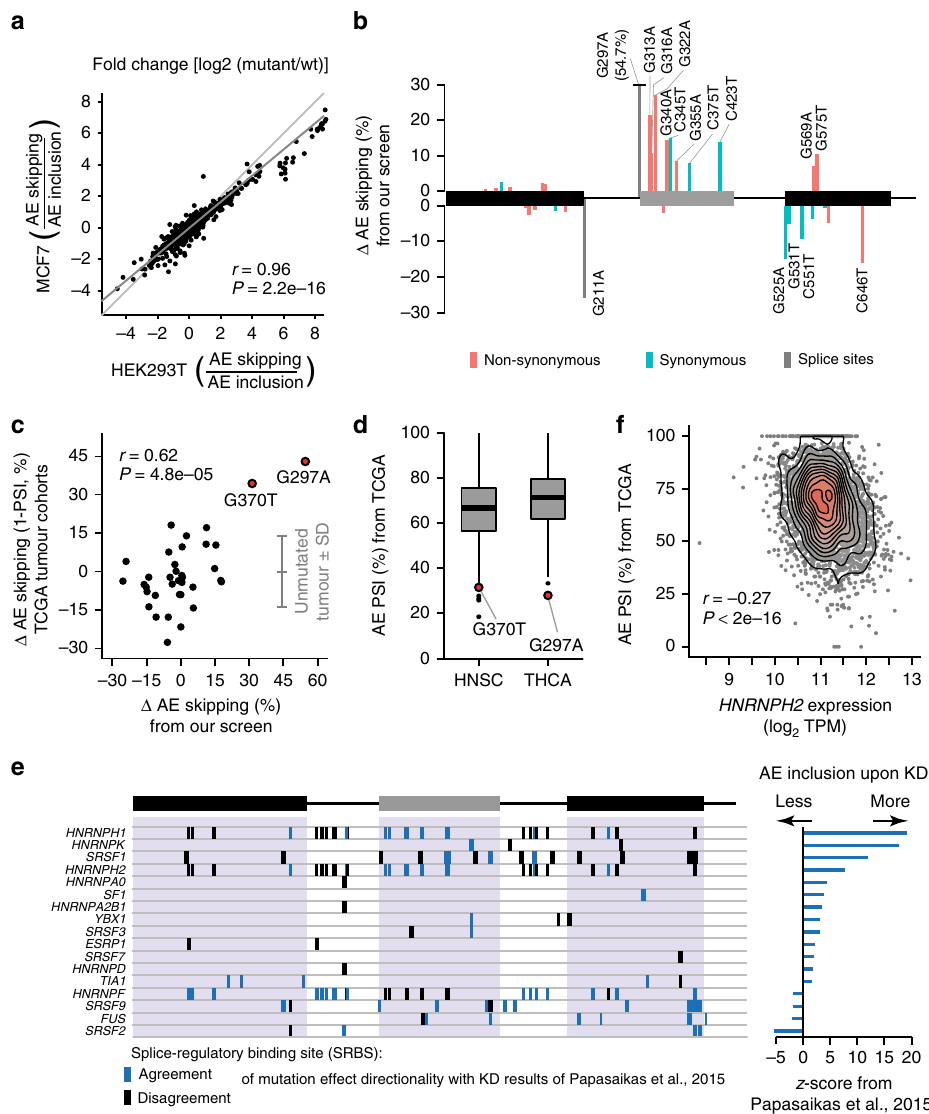
Fig. 3 Mutation effects are recapitulated in human cancer patients and point to regulatory RNA-binding proteins. a Model-inferred single mutation effects are consistent between HEK293T and MCF7 cells. Scatterplot compares changes in splice isoform ratios for mutations along RON minigene. Light and dark grey lines correspond to diagonal and linear regression, respectively. r , Pearson correlation coef fi cient and associated P value. b Somatic mutations in cancer can cause signi fi cant splicing effects. Bar diagram displays changes in AE inclusion for 33 mutations from COSMIC database. Mutations with signi fi cant effect on AE skipping are labelled ( n = 16). Orange, blue and grey indicate non-synonymous, synonymous and splice site mutations, respectively. Mutation G297A extends beyond visualised range. c Mutation effects from our screen recapitulate altered splicing in cancer patients. Scatterplot compares RON AE skipping between mutated and non-mutated TCGA tumour samples (percent spliced-in, PSI) from 117 cancer patients (with 36 different mutations in 14 cohorts) to mutation-induced change in AE skipping in MCF7 cells. Grey lines indicate mean and standard deviation of unmutated tumour samples. r , Pearson correlation coef fi cient and associated P value. r = 0.27, P value = 0.12 without two mutations with strongest impact (G370T and G297A). d Tumour samples from mutation-bearing patients show strong RON exon 11 skipping. Boxplot summarises RON exon 11 inclusion (PSI) in head – neck squamous cell carcinoma (HNSC) and thyroid carcinoma (THCA) cohort. Box represents quartiles, centre line denotes 50th percentile and whiskers extend to most extreme data points within 1.5× interquartile range. Tumour samples with mutations G370T and G297A are labelled. e In silico predictions for RNA-binding proteins (RBPs) identify splice-regulatory binding sites (SRBS; predicted binding sites that show substantial mutation effects, see Methods). Boxes indicate SRBS for 17 putative RBP regulators that overlap with published data on RON exon 11 splicing upon RBP KD 35 . Colour code indicates whether majority of mutation effects within SRBS agree with direction of published RBP KD effect ( z -scores; right panel). f HNRNPH2 shows strongest correlation of expression levels with RON exon 11 splicing across 27 tumour cohorts. Density scatterplot shows HNRNPH2 expression (in transcripts per million, TPM) and RON exon 11 PSI across all TCGA tumour samples. r , Spearman correlation coef fi cient and associated P